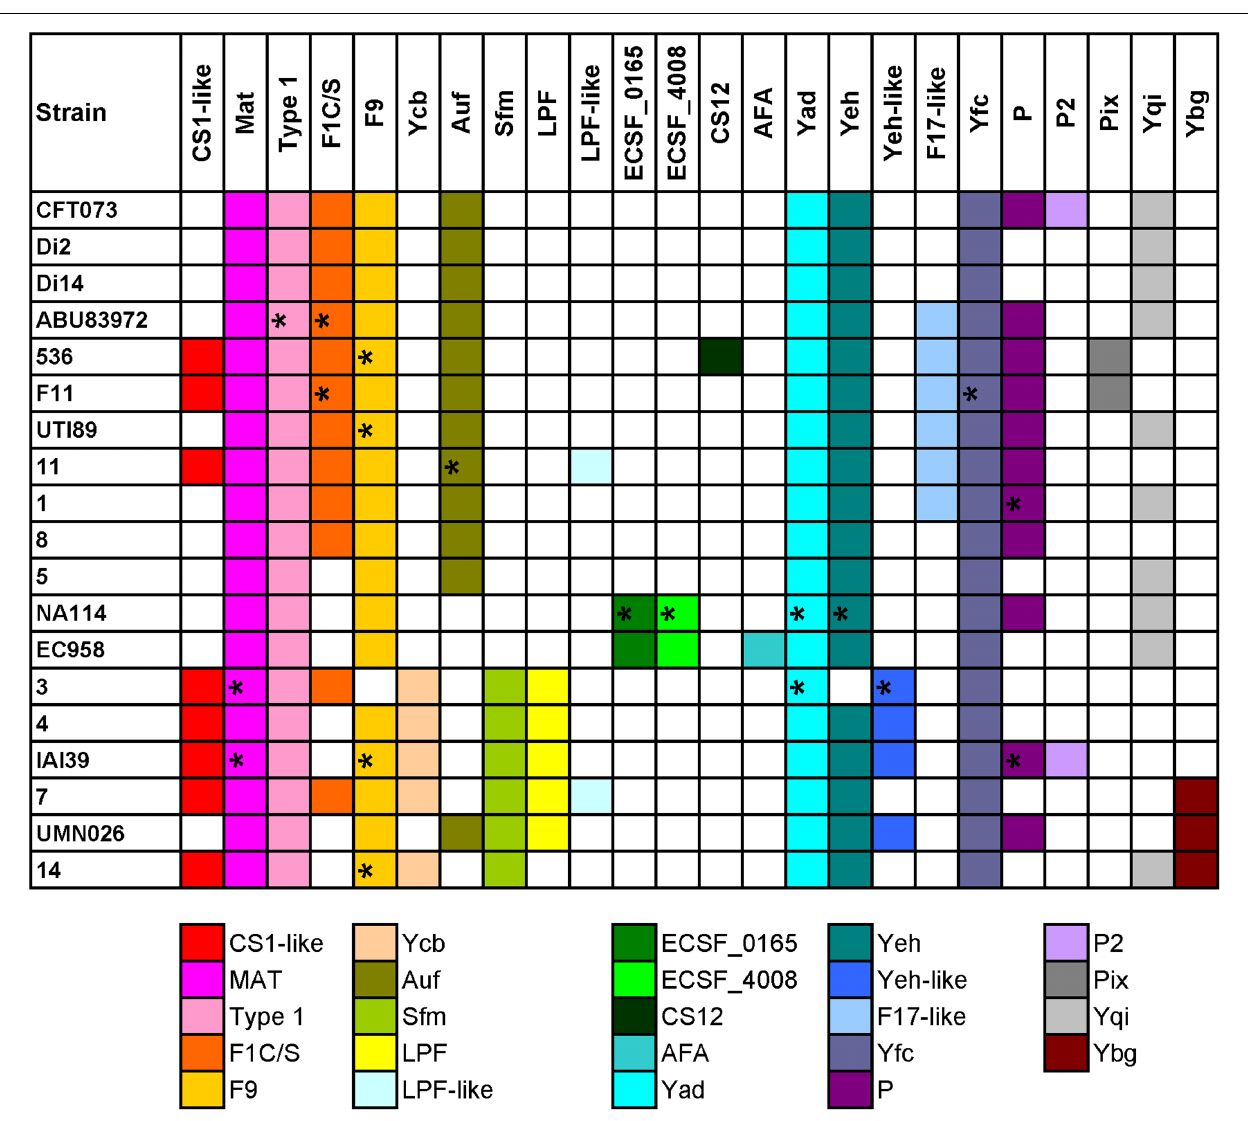
FIGURE 2 | Distribution of chaperone-usher fimbrial operons in 19 UPEC strains. The name of the fimbriae is shown at the top. Each color box is representative of a certain type of chaperone-usher fimbrial operon, as indicated below the figure. The fimbriae operons not complete are indicated by ∗